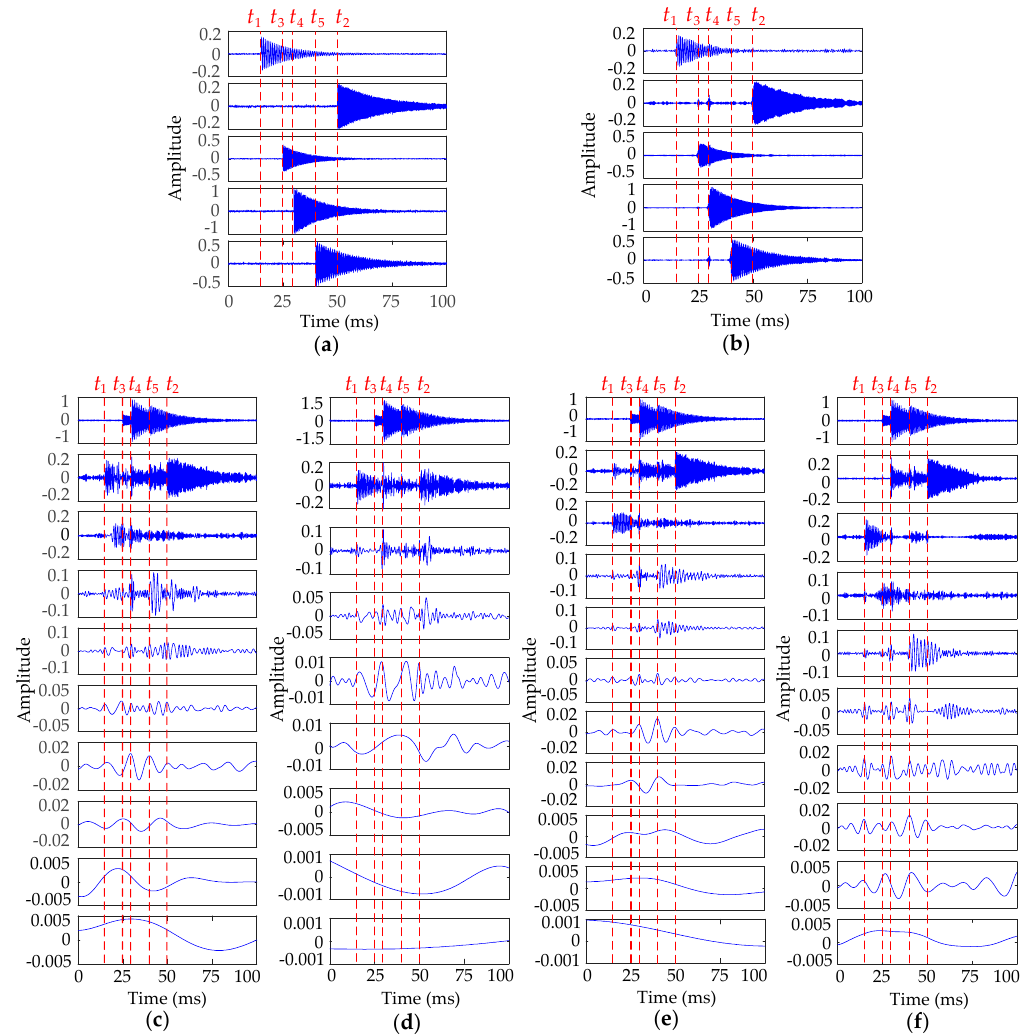
Figure 4. ( a ) Original vibration events; ( b ) IMFs decomposed by VMD method; ( c ) IMFs decomposed by EMD method; ( d ) PFs decomposed by LMD method; ( e ) IMFs decomposed by EEMD method; ( f ) IMFs decomposed by CEEMD method.